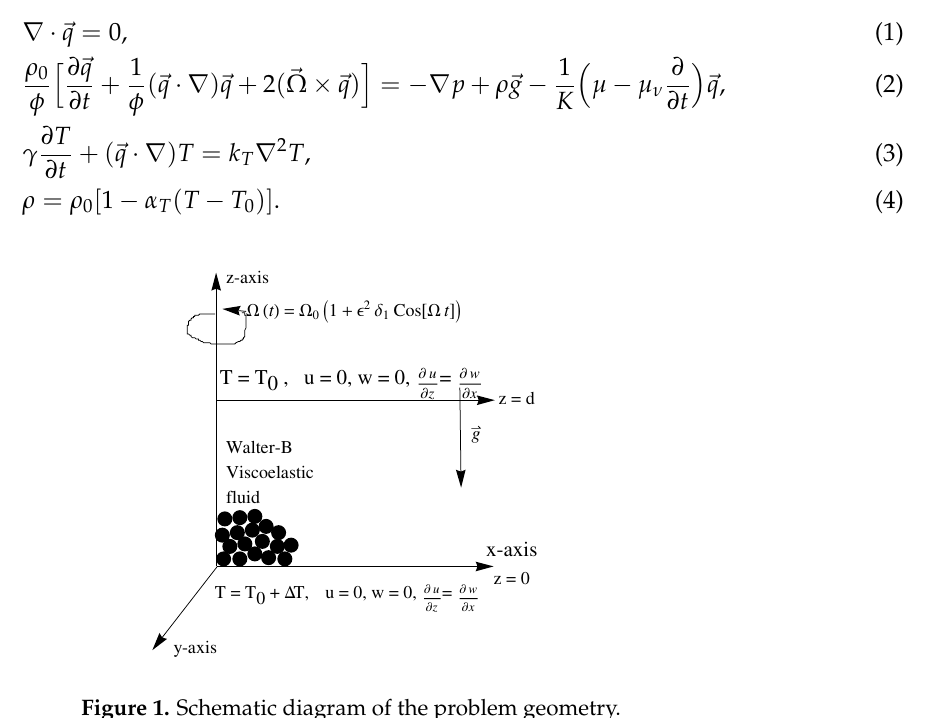
Figure 1. Schematic diagram of the problem